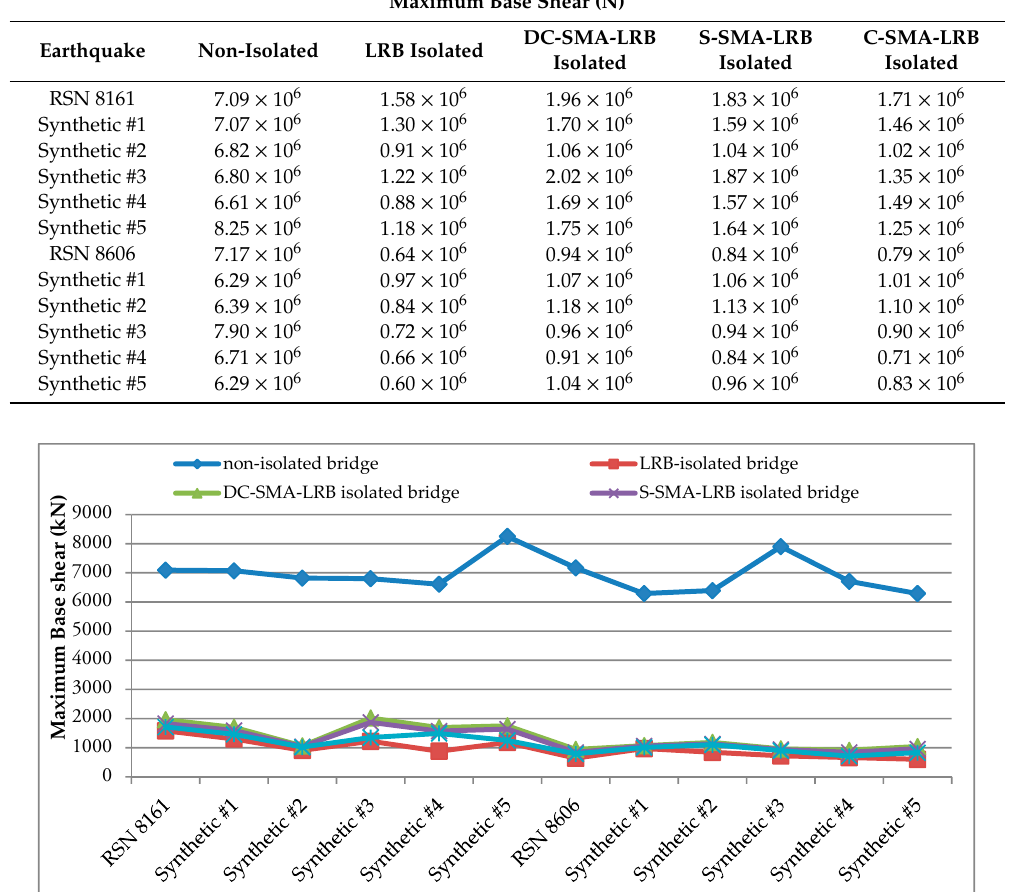
Figure 12. Graphical demonstration of the base shear for the non-isolated, LRB-isolated and three SMA-LRB isolated bridges.